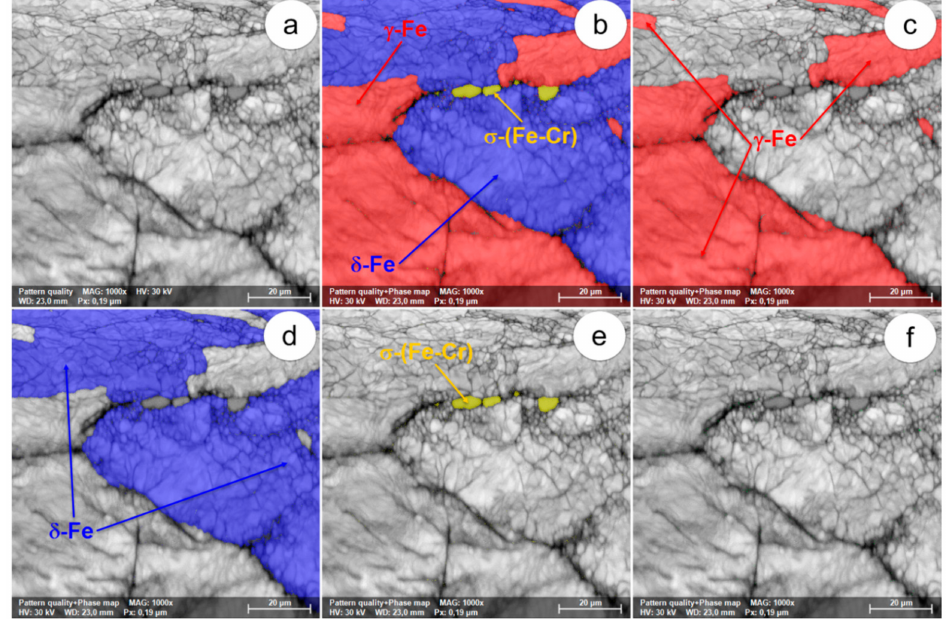
Figure 13. The SEM-EBSD composite images ( × 1000) obtained after forging at 1000 ◦ C: ( a ) the microstructure of the analysed field; ( b ) the distribution of existing phases in the microstructure of the analysed field; ( c ) the distribution of the γ -Fe phase; ( d ) the distribution of the δ -Fe phase; ( e ) the distribution of the σ -(Fe-Cr) phase; ( f ) the distribution of the χ -(Fe-Cr-Mo)